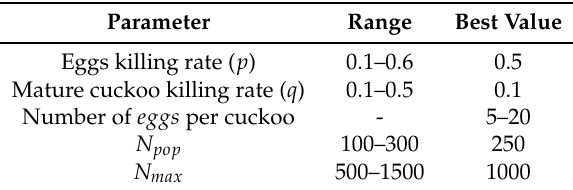
Table 4. Algorithm